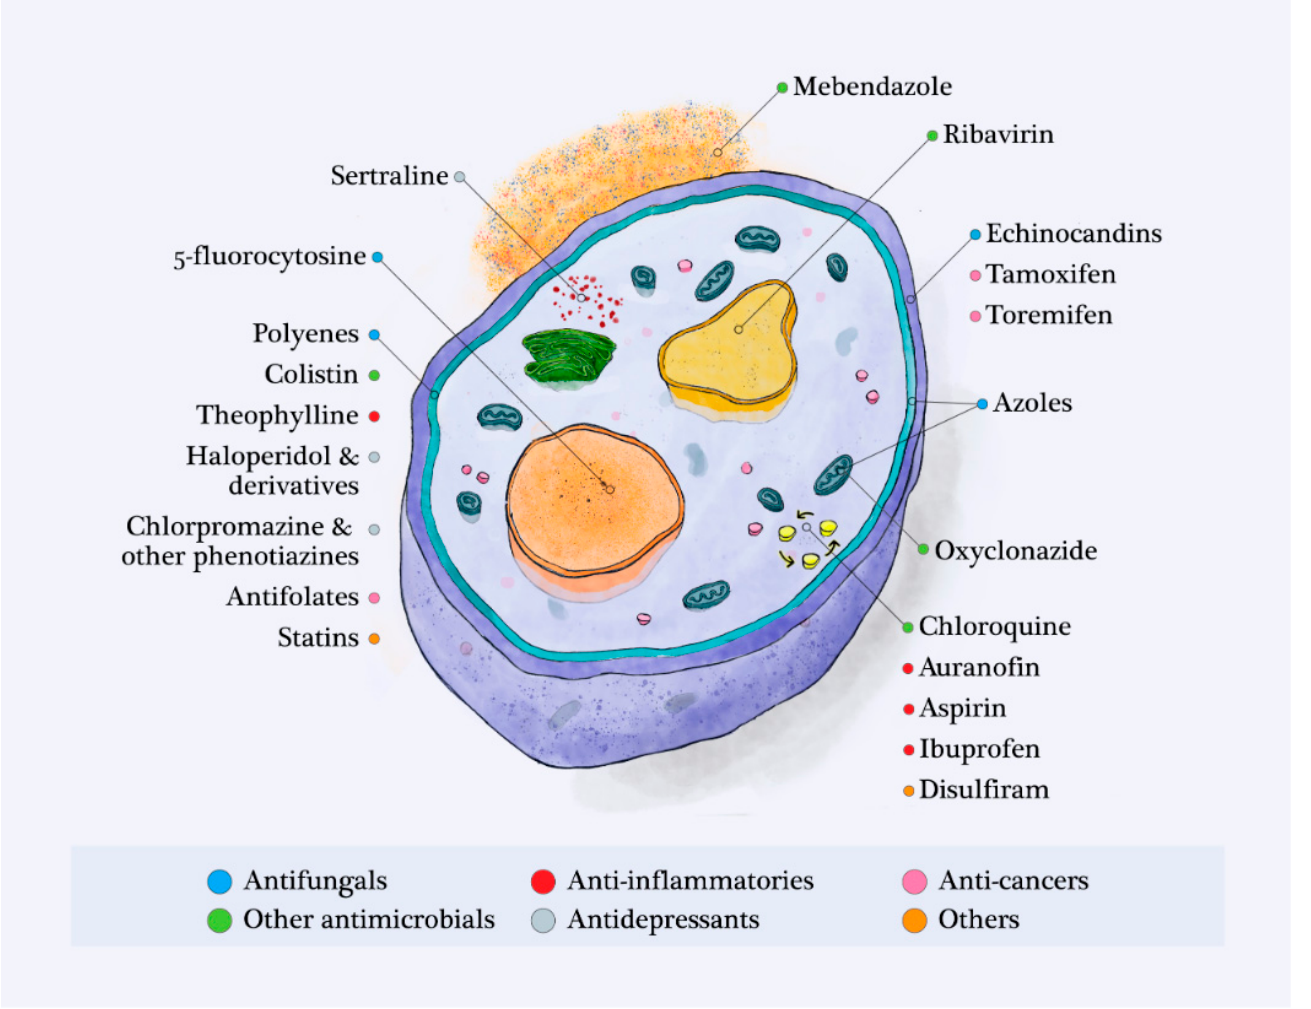
Figure 1. Therapeutic targets in the fungal cell of the compounds listed in the review: known antifungals and molecules that have a potential for repurposing as